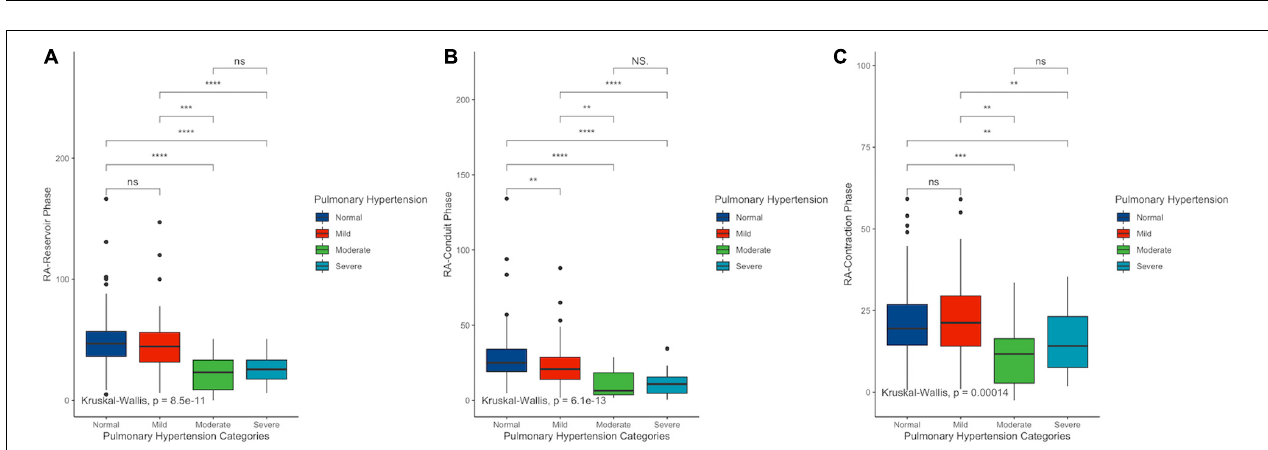
FIGURE 4 | Correlation of the absolute values of RV-FWS (A) and RA-GS (B) with logarithmical sPAP. sPAP, systolic pulmonary arterial pressure; RV-FWS, right ventricular free wall strain; RA-GS, right atrial global longitudinal strain.